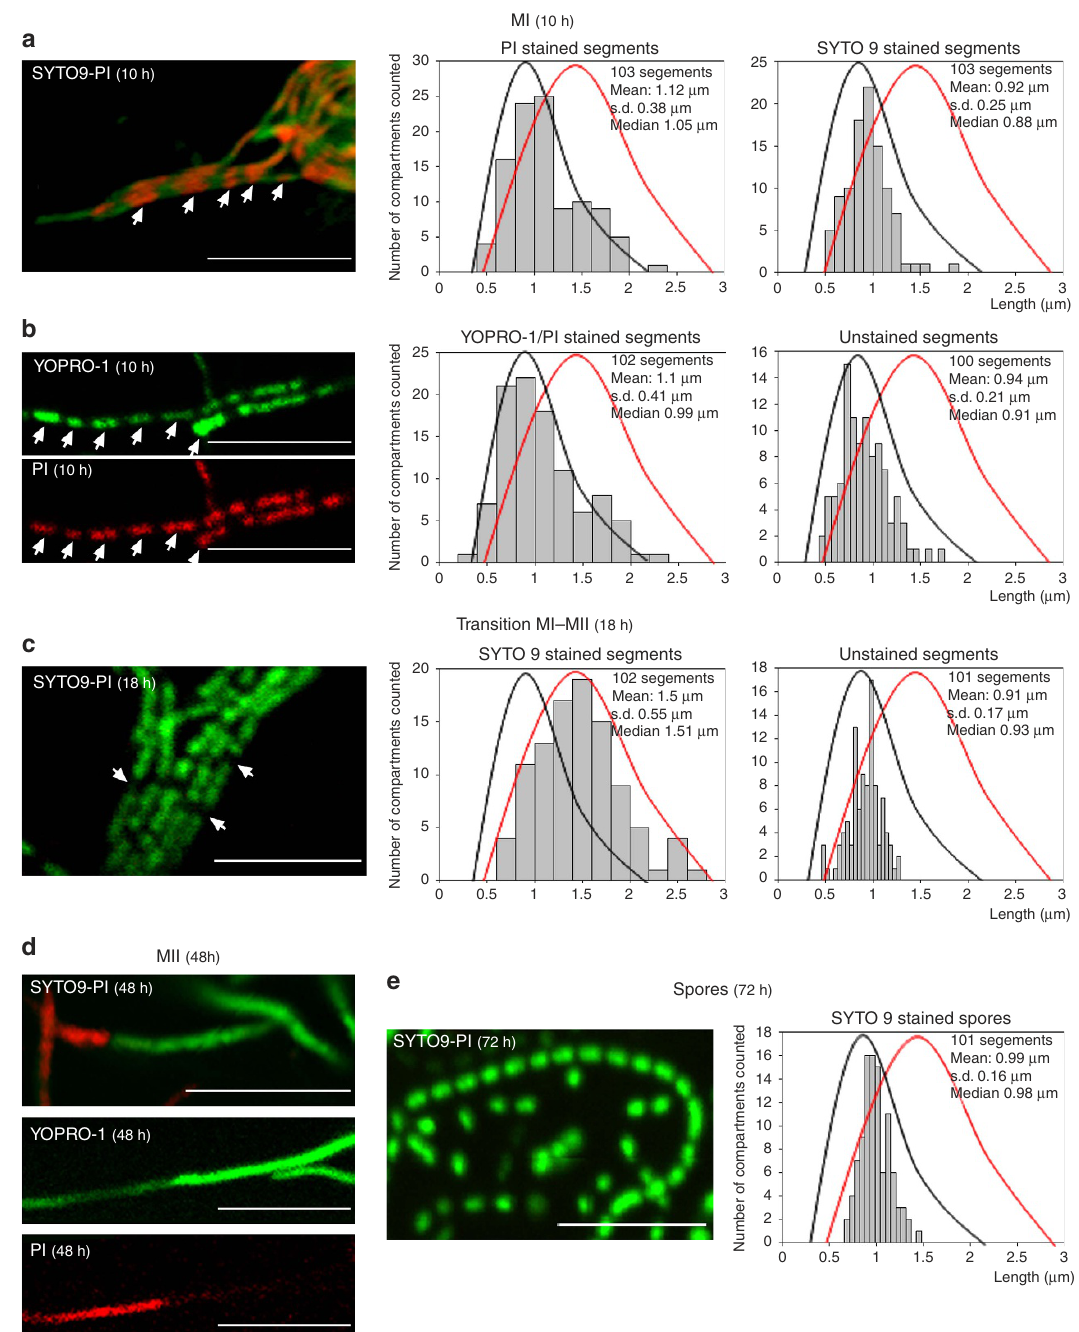
Figure 2 | Confocal laser scanning fluorescence microscopy analysis of S. coelicolor growing on GYM agar. ( a ) SYTO9 (green) and PI (red) staining (MI, 10h). ( b ) YOPRO-1 (green) and PI (red) staining (MI, 10h). ( c ) SYTO9-PI staining (transition from MI to MII, 18h). ( d ) SYTO9-PI staining and YOPRO-1-PI (MII, 48h). YOPRO-1 and PI were usezd simultaneously; notice that not all of the hyphae stained with YOPRO-1 were stained with PI. ( e ) SYTO9-PI staining (spores, 72h). The scale bars correspond to 8 m m. The arrows in a – c highlight dying cells in ‘MI’ and ‘transition MI-MII’ hyphae. Histograms of the stained and unstained segments are shown. Two distributions were observed: one from the MI stained and unstained segments in a and b and from the unstained segments in c (black lines), and the second from the living segments stained with SYTO9, which begin to enlarge as multinucleated hyphae in c (red lines). A regular pattern of permeable and non-permeable cells was During the last developmental stages, the hyphae compart- not observed during the MII stage, once the dying MI cells mentalized into spores with an average diameter of disintegrated 6 , while live cells grew out to form non-septated 0.99 ± 0.16 m m and a size distribution comparable to that of the multinucleated hyphae (Fig. 2d). This indicates that the regular MI segments (compare Fig. 2a–c with Fig. 2e). Sporulating septa pattern of YOPRO-1/PI staining observed in the MI hyphae is consisted of very thick cell walls that were not stained by nucleic attributable to the nature of this mycelium, which differs from acid-binding stains and were observed as unstained regions that of the MII hyphae. (Fig. 2e; notice that the length of the unstained regions NATURE COMMUNICATIONS|7:12467|DOI: